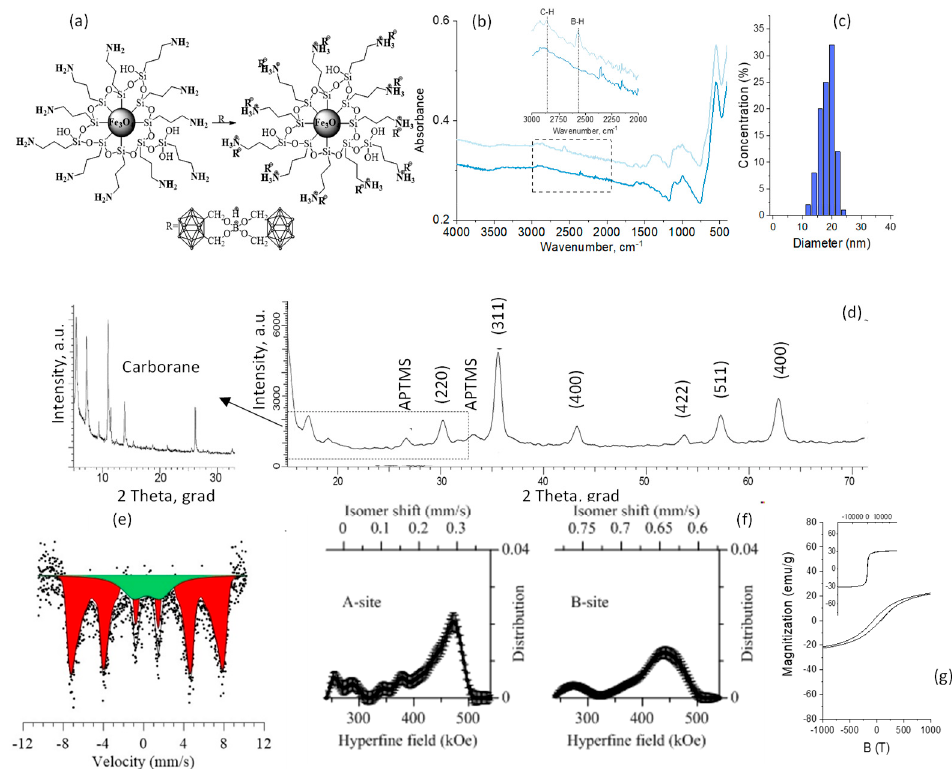
Figure 6. Characteristics of the system magnetic nanoparticles + APTMS + Carboranes. ( a ) Schematic representation of carborane derivatives immobilization; ( b ) FTIR spectra; ( c ) size distribution; ( d ) XRD diffractogram; ( e ) Mössbauer spectra; ( f ) the distribution of the hyperfine magnetic field; ( g ) hysteresis loop. Table 3. Element ratio variations by using the EDX method of Fe 3 O 4 nanoparticles with carborane.